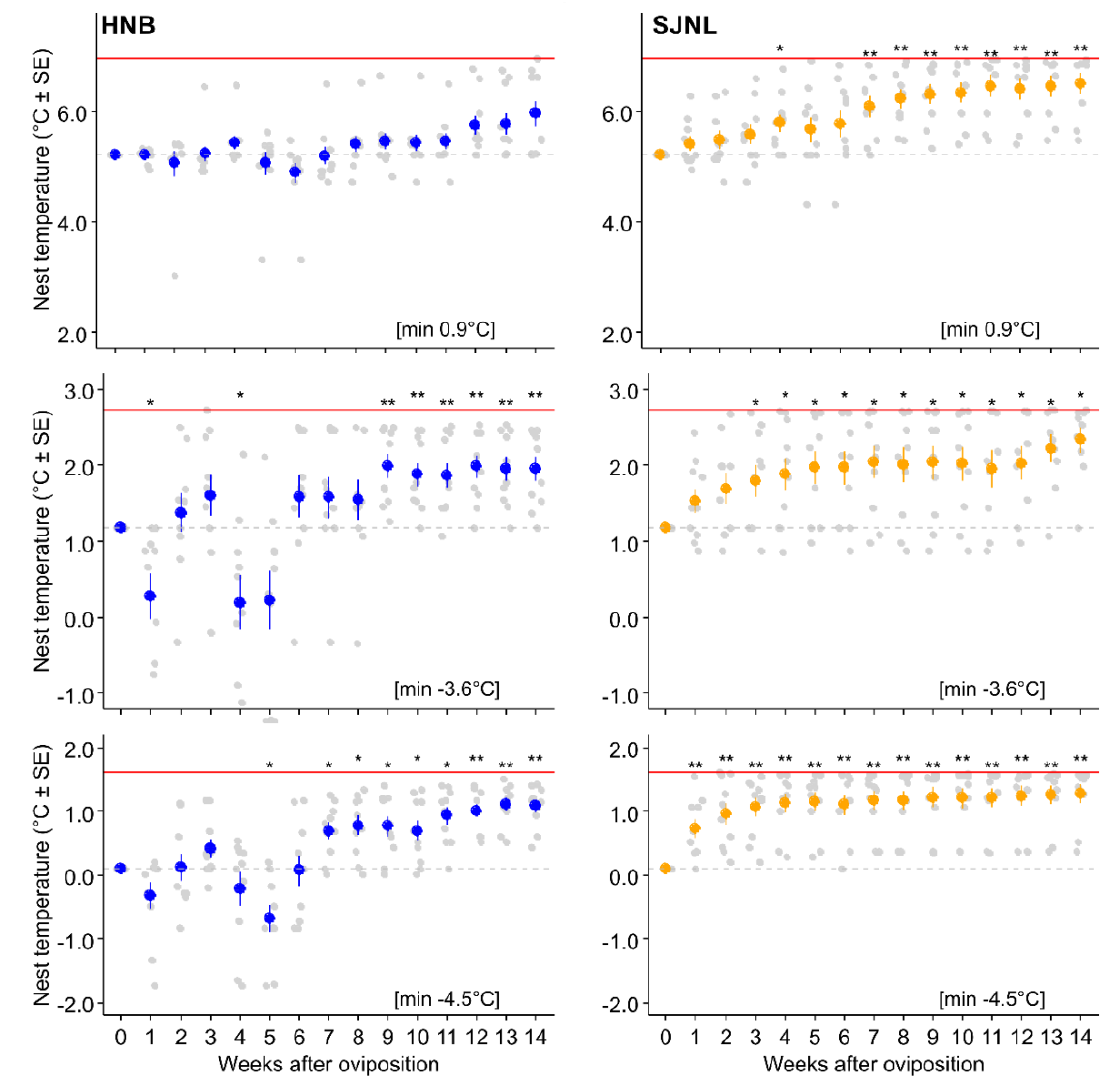
Figure 4 – Effect of population and temperature range on egg location during the 15 weeks following oviposition. Brackets indicate thermal ranges. Dashed grey lines indicate the location of mothers and eggs when the experiment was set up. The maximum temperature of each area is indicated with a red line, while its minimum temperature is provided between brackets. Grey dots are jittered experimental values for each clutch of eggs. Coloured dots are mean values ± SE per week. Exact Mann-Whitney tests to compare values of each week to the initial temperature: **P<0.01, *P<0.05. P-values corrected for multiple comparisons. HNB: Harvey Station. SJNL: St